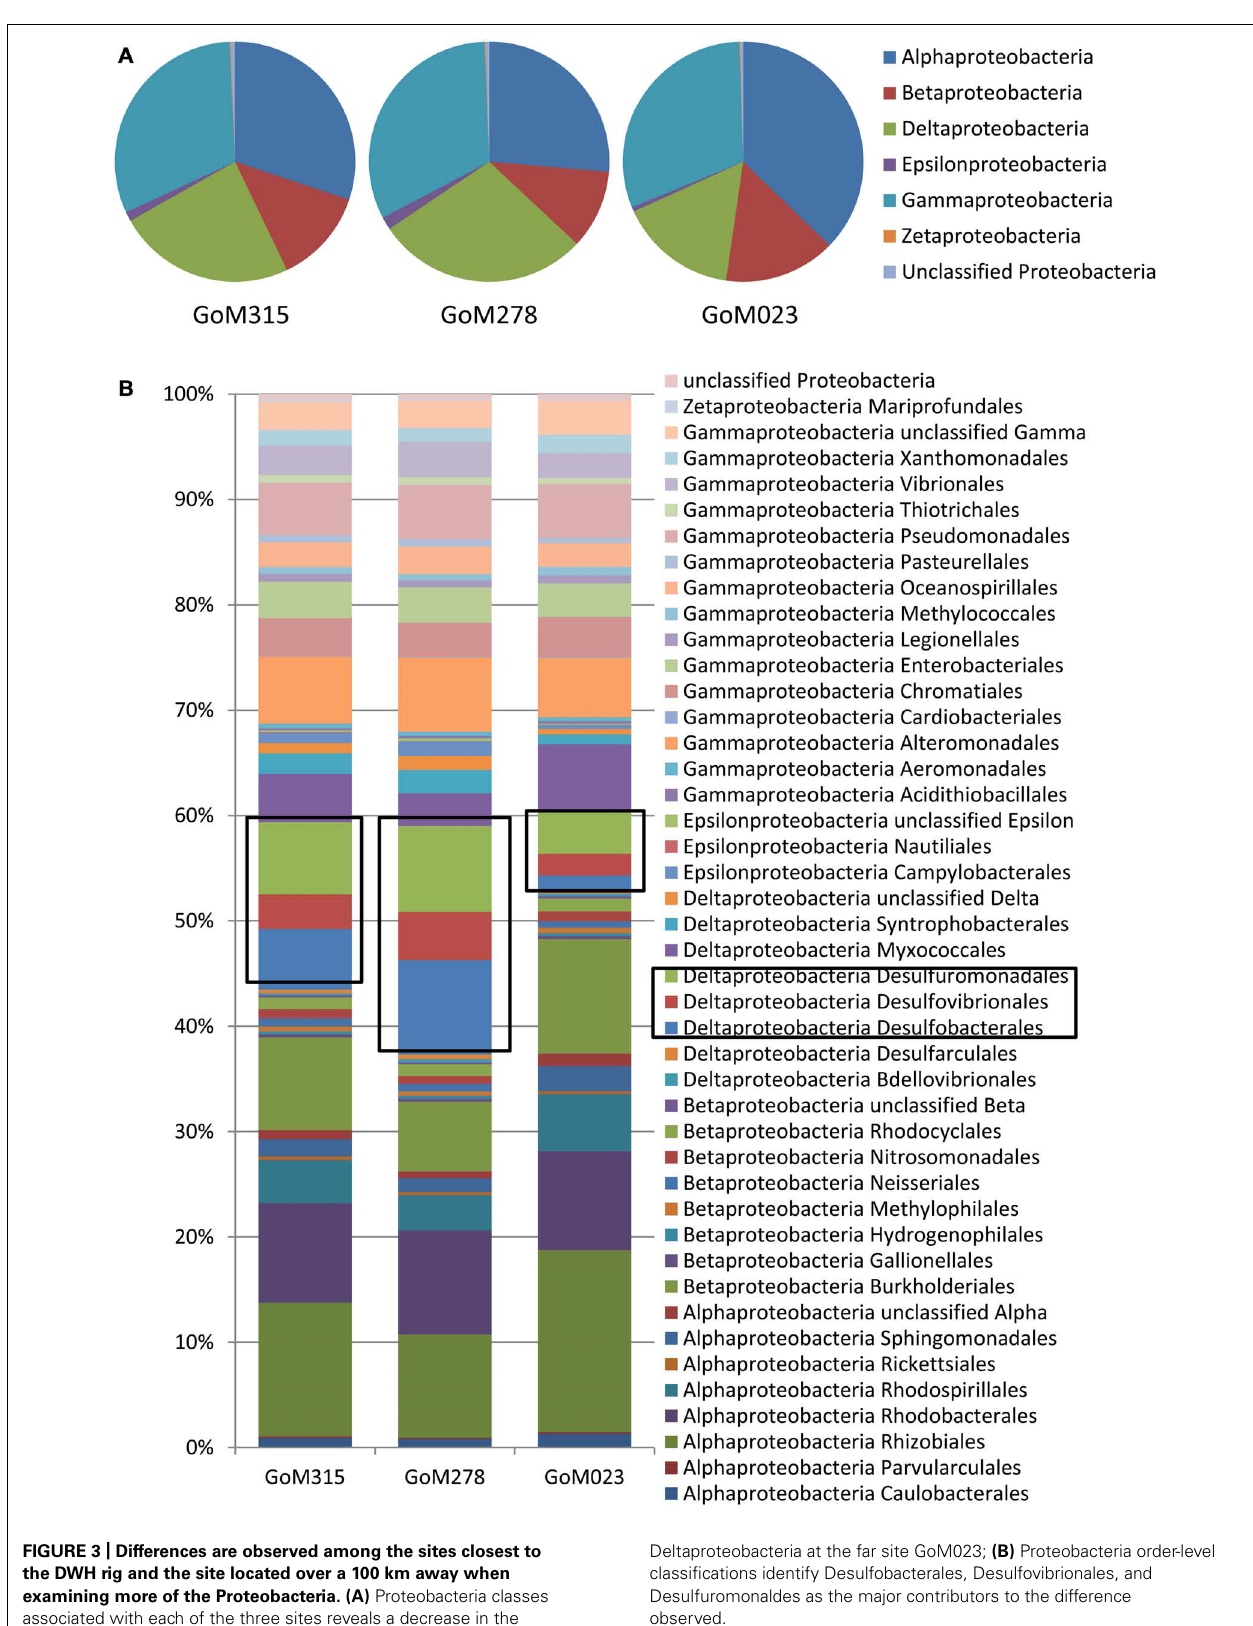
Deltaproteobacteria at the far site GoM023; (B) Proteobacteria order-level classifications identify Desulfobacterales, Desulfovibrionales, and Desulfuromonaldes as the major contributors to the difference